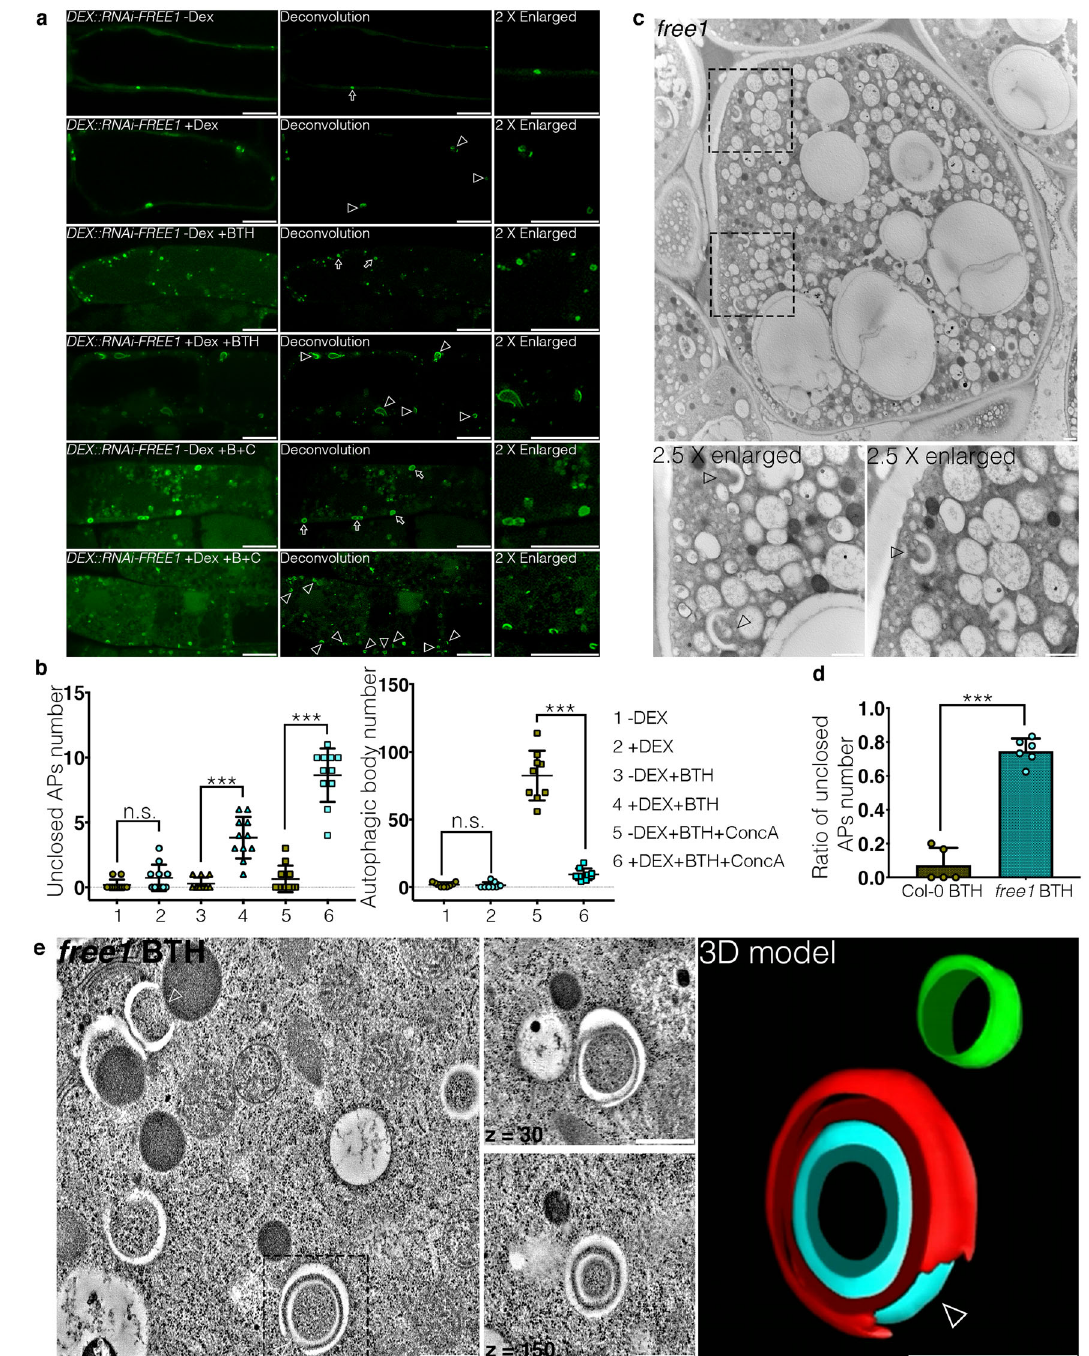
Fig. 1 | FREE1 mutants accumulate unclosed autophagosomes. a Transgenic Arabidopsis seedlings expressing YFP-ATG8e in dexamethasone-inducible FREE1 RNAi ( DEX::RNAi-FREE1 ) mutants were subjected to mock or autophagy inductions by BTH (Benzothiadiazole, B) or BTH and ConcA (Concanamycin A, C) with or withoutDEXtreatmentfor8hrsbeforeconfocallaserscanningmicroscopy(CLSM) observation. Images were further processed by Leica Huygens deconvolution. Arrows and arrowheads indicate the close and unsealed autophagosomal struc- tures, respectively. Scale bars, 10 μ m. b Quanti fi cation analysis of the numbers of unclosed autophagosomal structures in the cytoplasm (left panel) and autophagic bodies inside the vacuoles (right panel) per cross-cell section shown in a . Means ±SD; n =11 (left panel) and n =9 (right panel) individual cells per experimental group, one-way analysis of variance (ANOVA), followed by Tukey ’ s multiple test; *** p <0.001; n.s., not signi fi cant. c TEM (transmission electron microscopy) analysis of high-pressure freezing/frozen substituted homozygous free1 T-DNA insertional